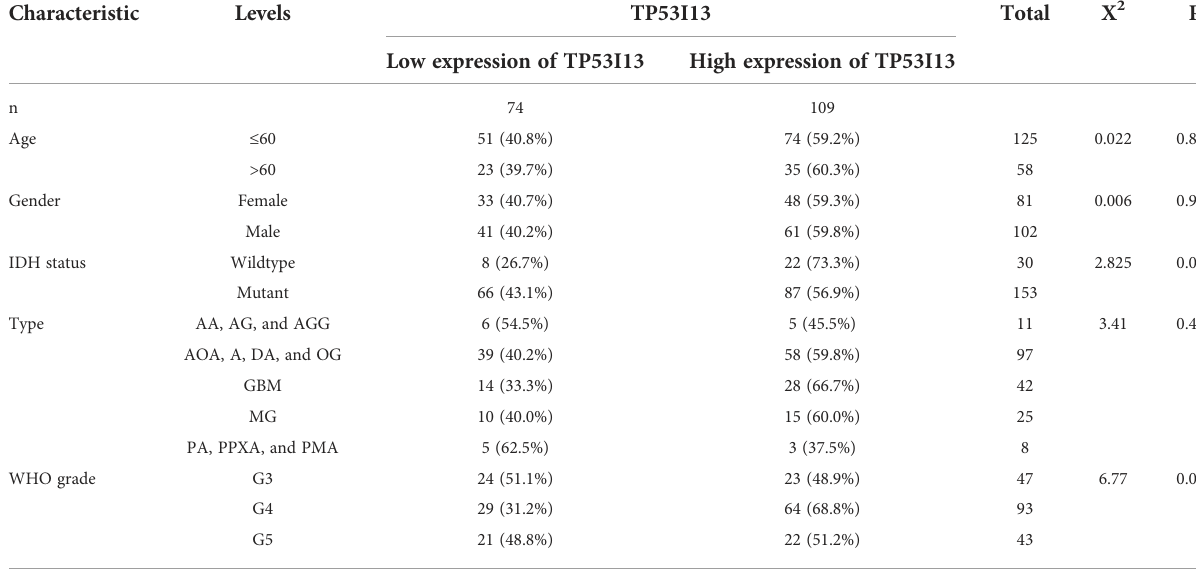
TABLE 3 MIHC analysis between TP53I13 expression level and different clinical characteristics based on samples from Nantong University Af fi liated Hospital.